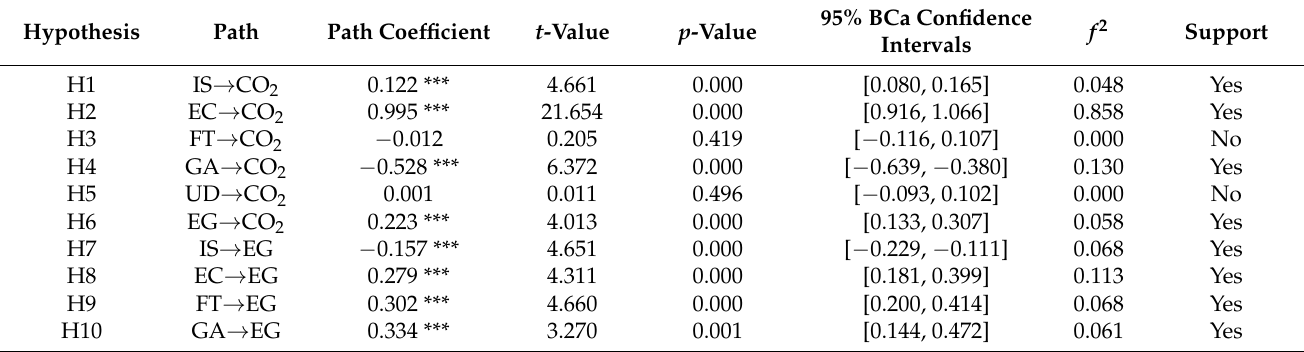
Table 2. Results of the hypothesis model.